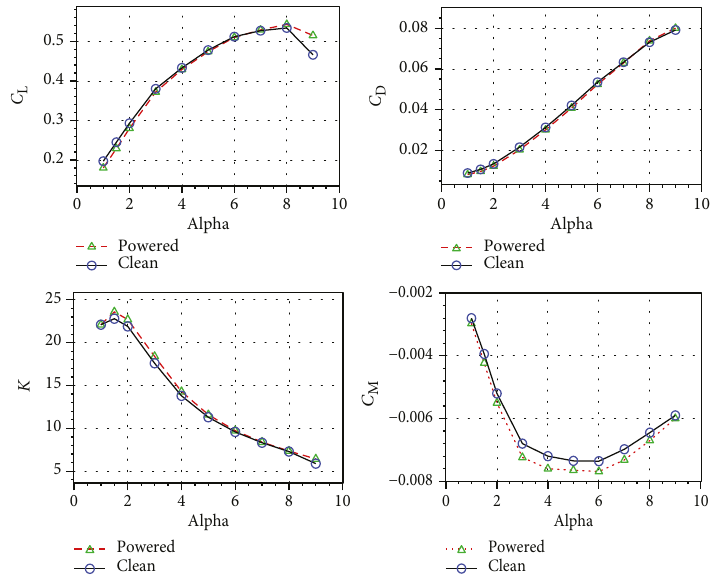
Figure 10: Comparison of aerodynamic forces for the clean and powered con fi gurations at high speed.